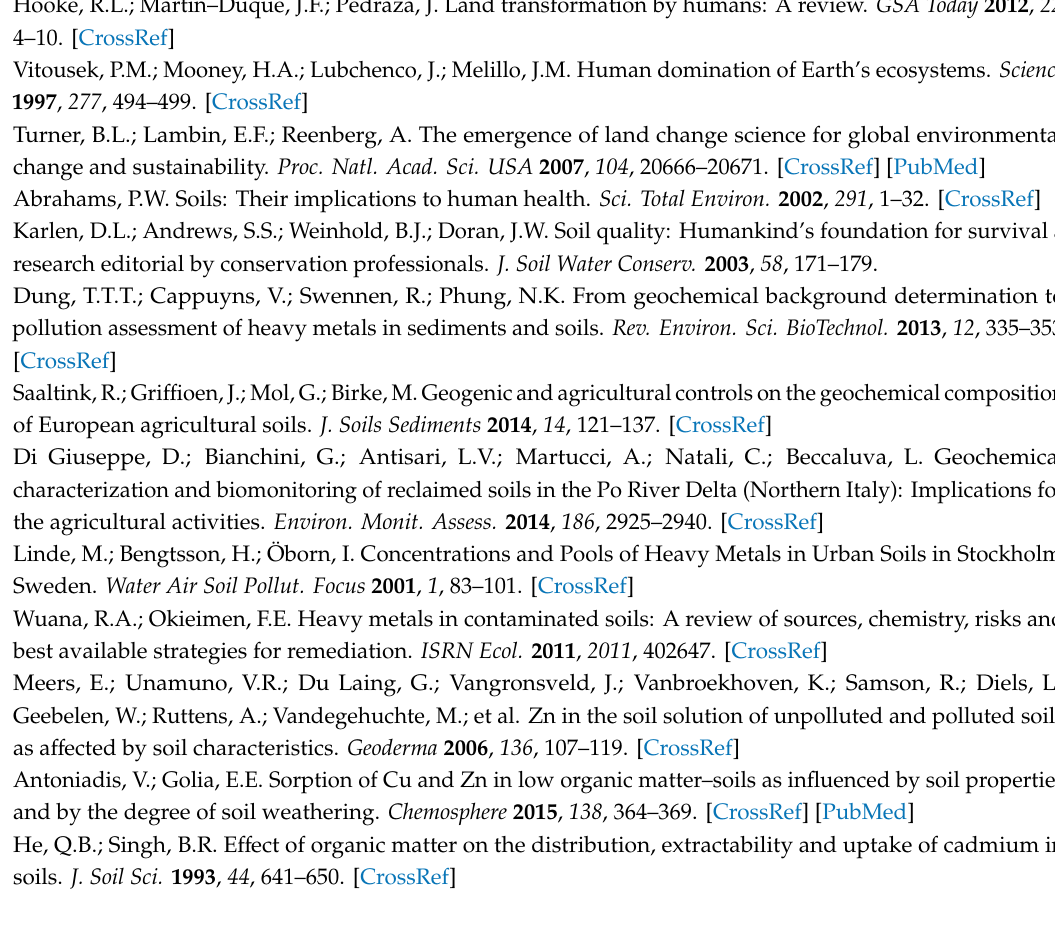
Figure S1: Linear regressions for potentially toxic elements among three di ff erent layers in sampling region (I: n = 29), A: The 0–20 cm soil layer; B: The 21–50 cm soil layer; and C: The 51–100 cm soil layer. Figure S2: Linear regressions for potentially toxic elements among three di ff erent layers in sampling region (II: n = 17), A: The 0–20 cm soil layer; B: The 21–50 cm soil layer; and C: The 51–100 cm soil layer. Figure S3: Linear regressions for potentially toxic elements among three di ff erent layers in sampling region (III: n = 29), A: The 0–20 cm soil layer; B: The 21–50 cm soil layer; and C: The 51–100 cm soil layer. Table S1: The detailed information for sampling sites. Table S2: Descriptive statistical analysis of Mn and potentially toxic elements (Zn, Cu, Cd, Ni, Co, and Mn) in three sampling region (I: n = 29; II: n = 17; III: n = 29), A: The 0–20 cm soil layer; B: The 21–50 cm soil layer; and C: The 51–100 cm soil